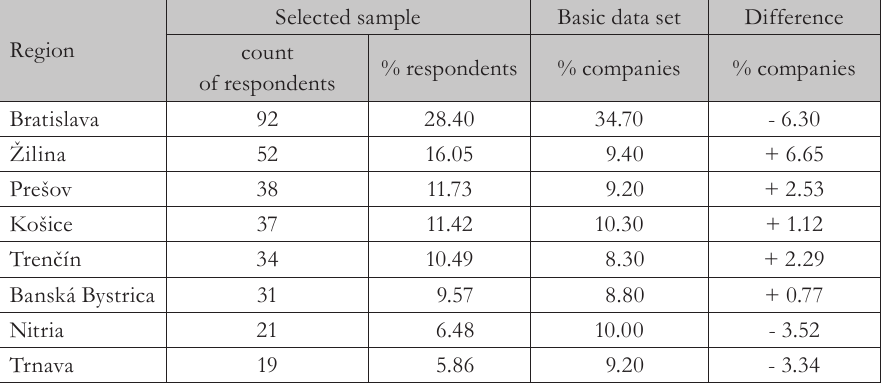
Tab. 2 - Regional Structure Comparison of Basic and Selection File. Source: NADSME